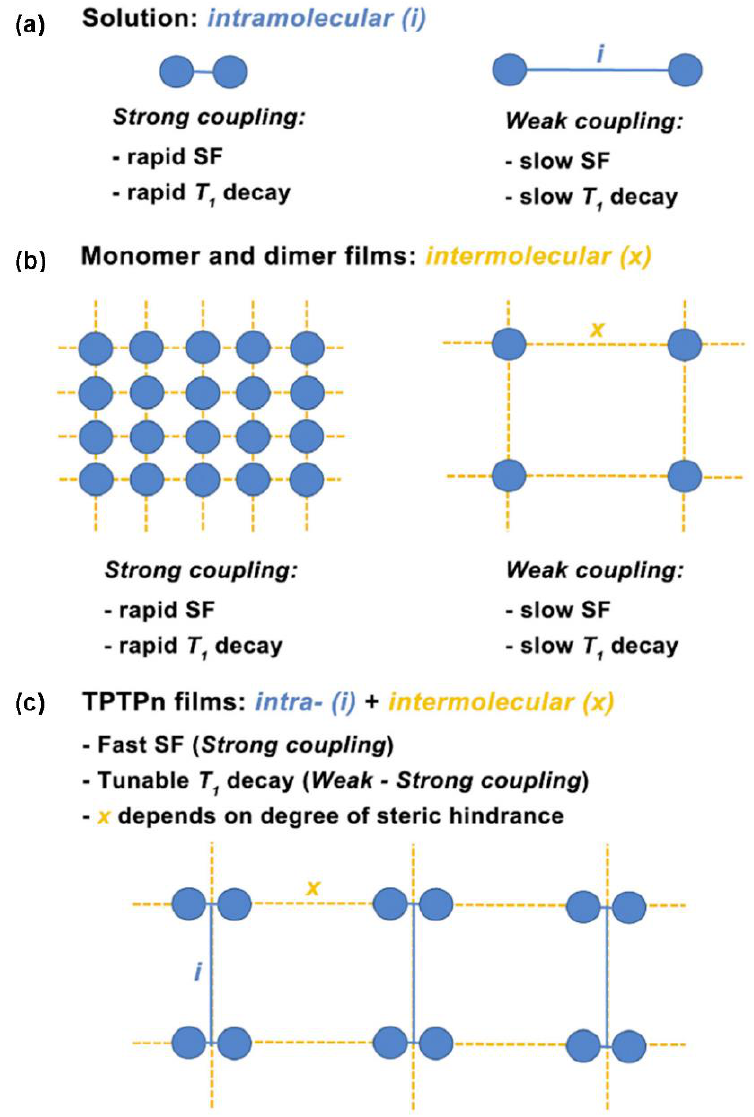
Figure 9. Summary of structure–function relations and the design strategy based on TPTPn com- pounds. Solid blue lines correspond to through-bond interactions, and dashed orange lines denote through-space interactions. ( a ) Typical solution-phase intramolecular SF dynamics. ( b ) Film dynam- ics for monomer and dimer materials. ( c ) The design strategy based on TPTPn compounds. Reprinted with permission from Ref. [87]. Copyright 2019, Elsevier Inc.